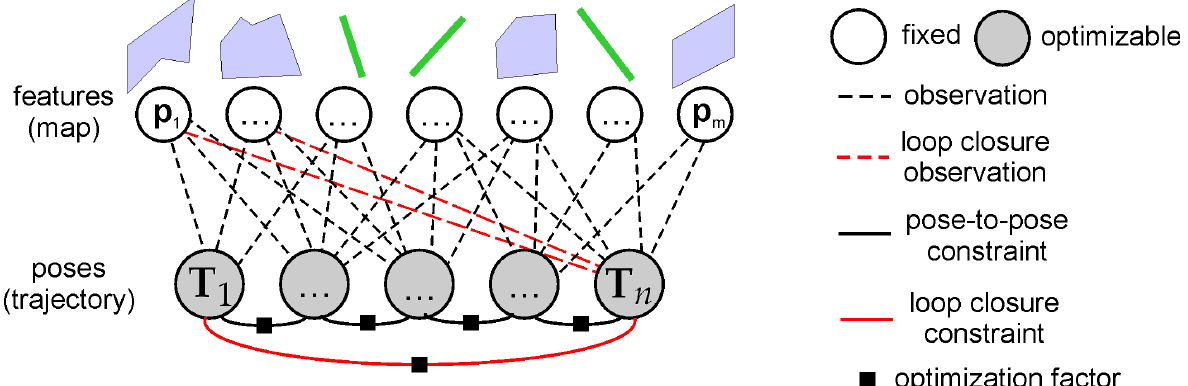
Figure 12. Pose graph optimization in PlaneLOAM is performed using the pose-to-pose constraints obtained from the mapping thread. These constraints join consecutive poses in the trajectory. Loop closure constraints join two distant poses, and are established upon segment-based loop closure detection. Features stored in the map are not included in optimization, as in the pose graph the observations are aggregated into pose-to-pose